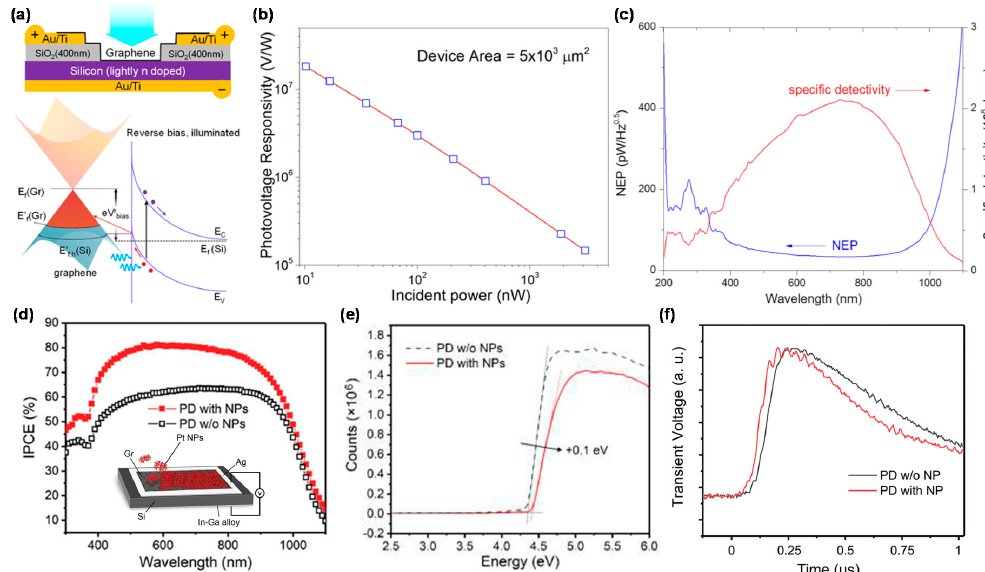
Figure 1. ( a ) Schematic diagram and band structure of a typical monolayer graphene/Si heterojunction device. Application of a reverse bias raises E f (graphene: Gr) and opens up a large number of accessible states that can be occupied by photoexcited holes injected from Si under illumination; ( b ) Variation of the voltage responsivity as a function of incident power, obtained under the open-circuit condition. At the lowest powers, the voltage responsivity exceeds 10 7 V/W; ( c ) Spectral dependence of the NEP and specific detectivity ( D* ) in the photocurrent mode. Reproduced with permission for Figure 1a–c from 2013 Nano Letter [24]; ( d ) Incident photon conversion efficiency (IPCE) spectra of graphene-Si PDs with and without fractal Pt NPs. The inset shows schematic diagram of a Si-graphene PD with fractal Pt NPs; ( e ) Ultraviolet photoelectron spectroscopy data of graphene-Si PDs with and without fractal Pt NPs, showing the effect of physical doping on the Fermi level; ( f ) Transient photovoltage characteristics of graphene-Si PDs with and without fractal Pt NPs under 532 nm pulse laser. Reproduced with permission for Figure 1d–f from 2017 Advanced Optical Materials